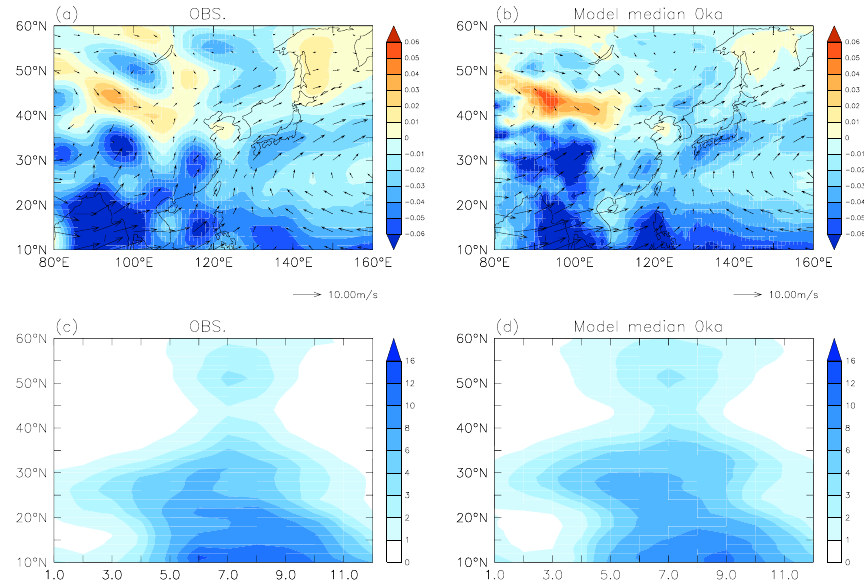
Fig. 2. (a) EASM monsoonal circulation in NCEP; (b) same as (a) but for the PMIP3 model median; (c) seasonal cycle of the EASM precipitation over eastern China (100–120 ◦ E averaged) (mmd − 1 ); (d) same as (a) but for the PMIP3 model median. Vectors are for the